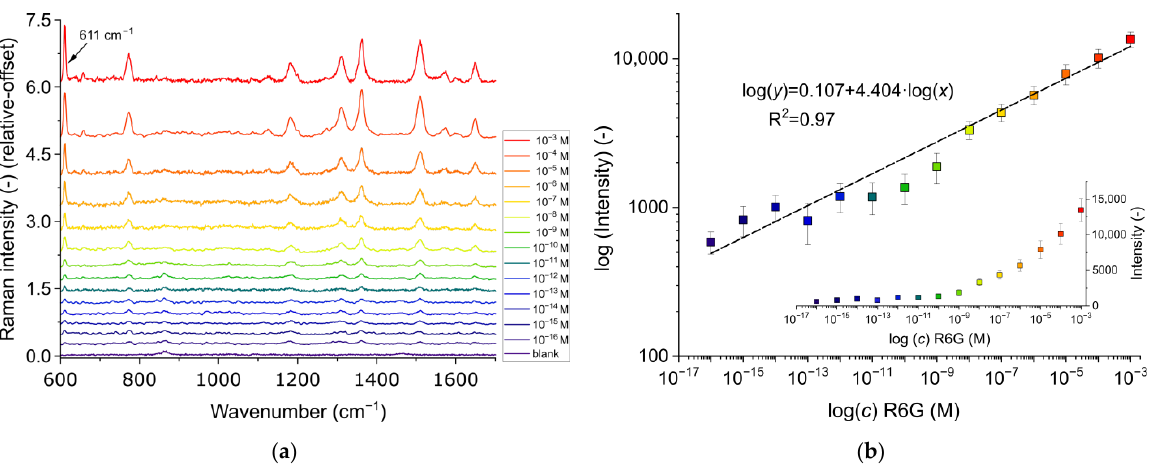
Figure 8. ( a ) Raman spectra measured on a type #2 substrate in a 25% ethylene-glycol/water mixture with different R6G concentrations, from 10 −3 M to 10 −16 M. The spectra are all baseline corrected and stacked on top of each other for the sake of presentation only. ( b ) The static characteristic of R6G determination calculated from the Raman intensity of the peak at 611 cm −1 . Every measurement point is an average of data obtained in five different points on the surface with standard deviation. The color scheme of different concentrations corresponds to the right figure ( a ). The top plot is in log-log scale with linear fitting; the insert in the bottom is in linear-log scale. By using the characteristic R6G peak at 611 cm −1 (corresponding to the bending of the C-C-C ring), the presence of R6G was still detectable at 10 −16 M concentration. It should be